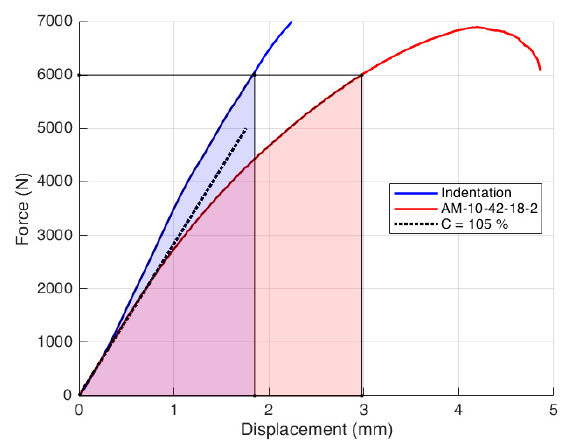
Figure 6. Fracture test curve (red), indentation curve (blue) and compliance line (black dotted line) in the case of the AM-10-42-18-2 test configuration.